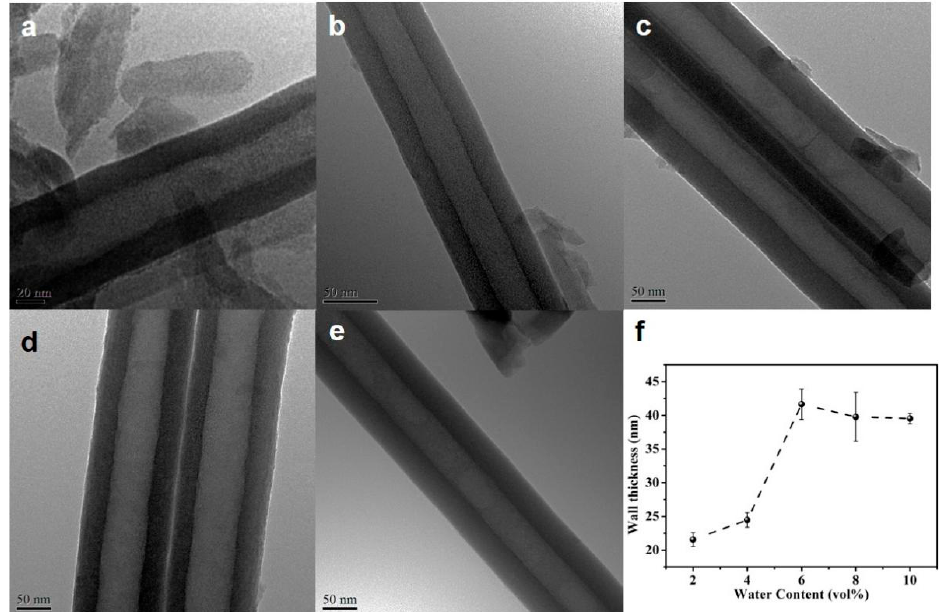
Figure 7. TEM images of the HEO nanotubes formed under 60 V in the ethylene glycol solution containing 0.1 mol/L NH 4 F and different amounts of DI water: ( a ) 2 vol.%, ( b ) 4 vol.%, ( c ) 6 vol.%, ( d ) 8 vol.% and ( e ) 10 vol.% after the anodization for 4 h; ( f ) Changes in nanotube wall thickness with anodization time.